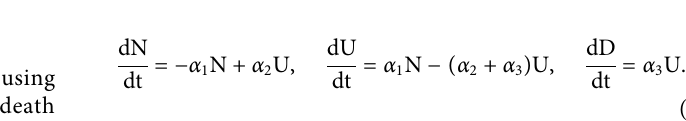
Frontiers in Physiology |